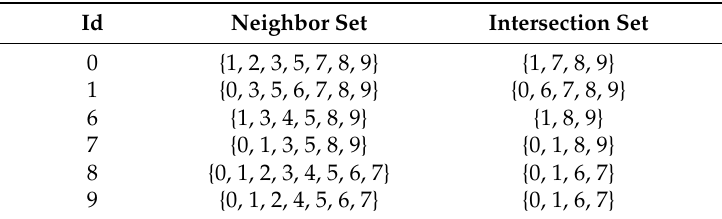
Table 2. LCC Intersection set